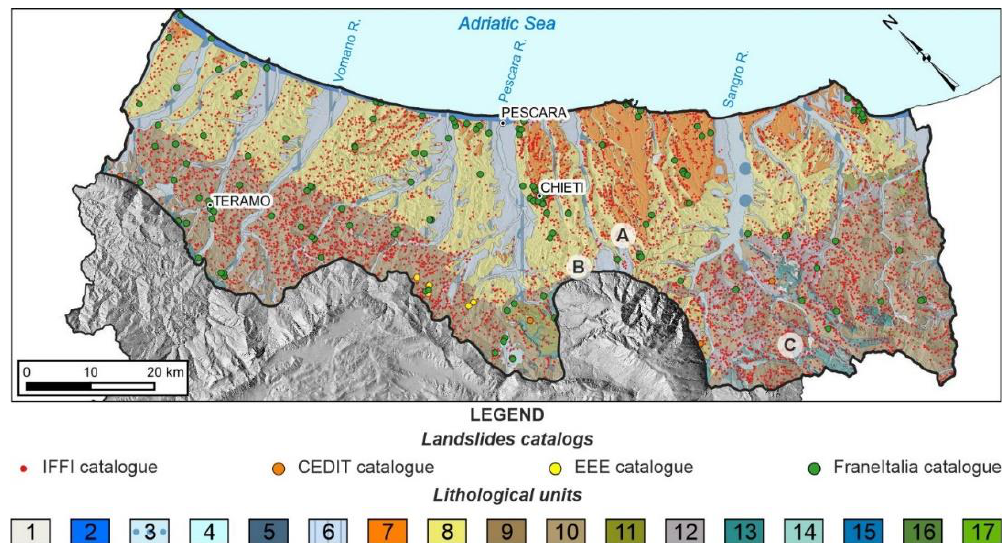
Figure 4. Lithological sketch map of the Abruzzo hilly piedmont area (modified from [56,57]) and spatial landslides distribution [60,61,64,65]. Legend: (1) eluvial–colluvial deposits; (2) sandy shore deposits; (3) recent fluvio-lacustrine deposits; (4) travertine deposits; (5) morainic deposits; (6) old fluvio-lacustrine deposits; (7) conglomeratic deposits; (8) clayey–sandy deposits; (9) sandy turbidites; (10) pelitic turbidites; (11) carbonate deposits in conglomeratic and calcarenitic facies; (12) allochthonous pelagic deposits; (13) carbonate ramp limestones; (14) basin limestones and marls; (15) slope limestone; (16) open carbonate shelf-edge limestones; (17) carbonate shelf limestones and dolomites. Capital letters in white circles locate the selected case studies. The black line represents the study area.